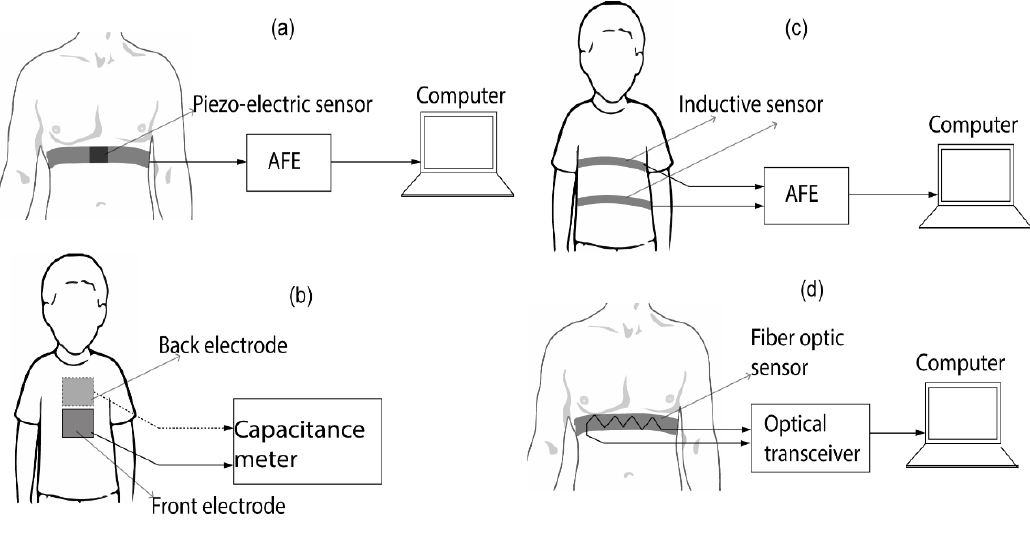
Figure 5. Strain-based sensing methods of breath rate: ( a ) resistive sensing, ( b ) capacitive sensing, ( c ) inductive sensing and ( d ) fiber-optic sensing.